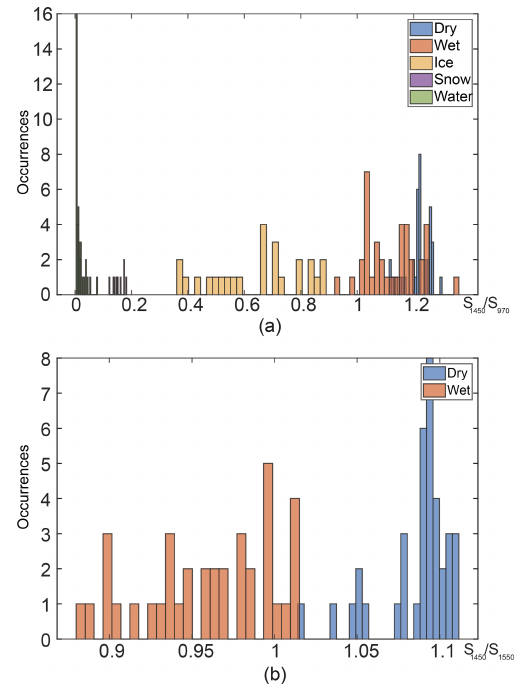
/S λ of dry, wet, ice, snow and Figure 10. (a) Histogram of S λ 1 2 water conditions with λ 1 = 1450nm and λ 2 = 970nm. (b) His- /S λ togram of S λ of dry and wet conditions with λ 1 = 1450nm 1 3 and λ 3 = 1550nm. Table 5. Characteristics of the